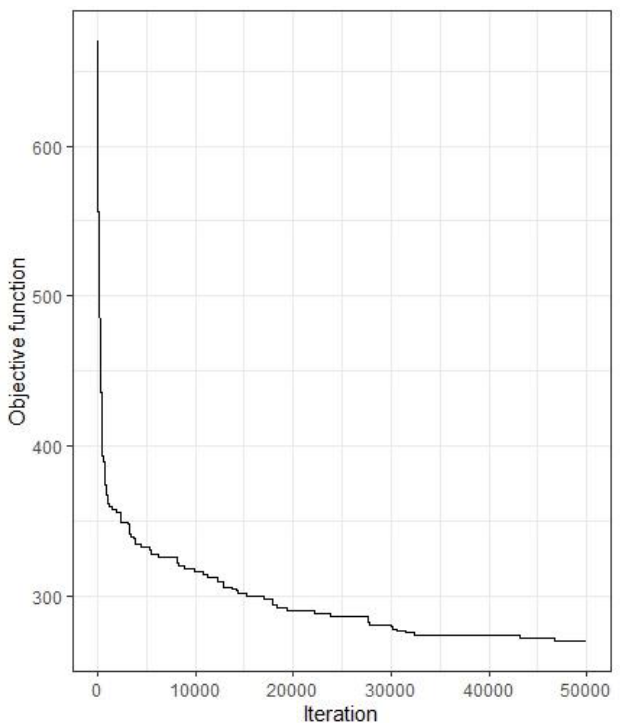
Figure 5. Iteration of selected parameters for CLHs.